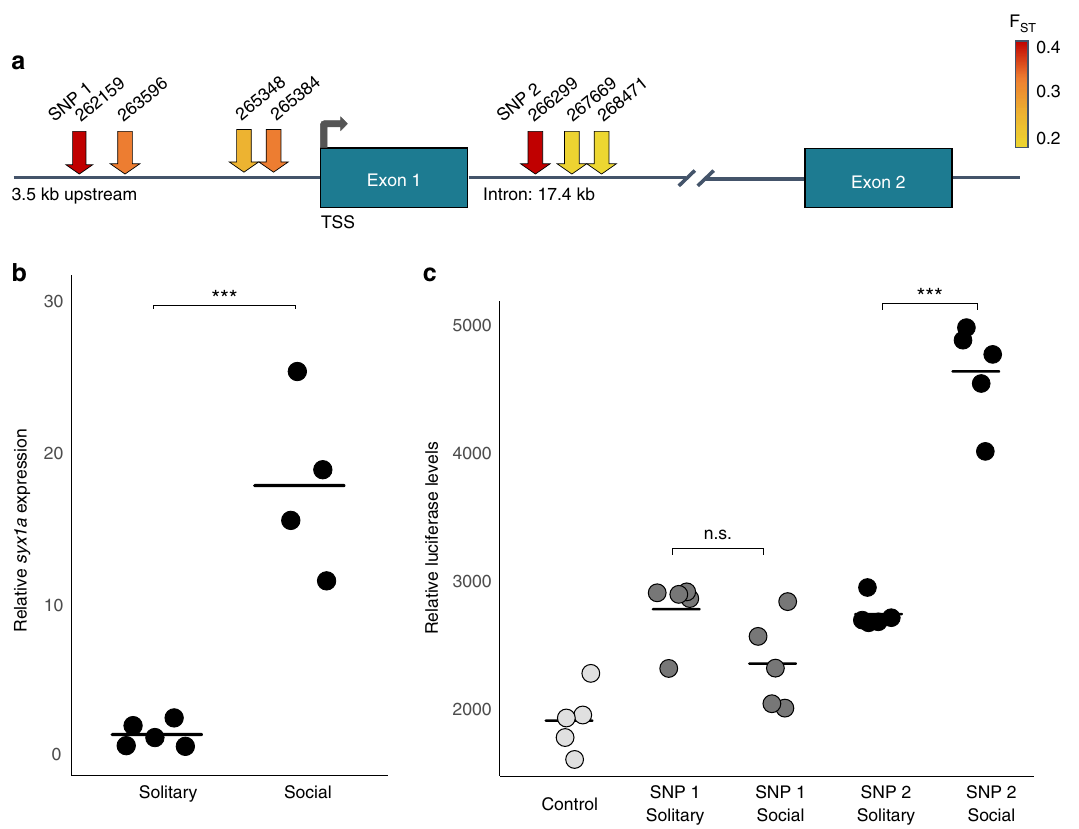
Fig. 4 Functional effects of regulatory SNPs in the syx1a locus. a Schematic of syx1a . Arrows denote locations of the seven SNPs associated with social behavior in L. albipes . Arrow colors illustrate F ST between social forms at each SNP. Two SNPs, labeled SNP 1 and 2 (red), have the highest F ST estimates, and are in strong LD with each other (r 2 = 0.803), compared with the mean pairwise value among all seven SNPs (r 2 = 0.18). b Quantitative PCR identi fi ed differences in syx1a brain gene expression between social forms. Expression values are plotted as the fold change of normalized syx1a expression levels. Social individuals ( n = 4) have signi fi cantly higher levels of syx1a brain gene expression than solitary individuals ( n = 5; t -test, t = − 6.32, p = 0.0004). c Luciferase reporter assays test if candidate SNPs in the regulatory regions of syx1a affect enhancer activity ( n = 5 replicates per group). Both tested regions show enhancer activity relative to control (Tukey ’ s honestly signi fi cant difference (HSD) post-hoc test, p < 0.05). There is no signi fi cant difference between social and solitary alleles of SNP 1 (Tukey ’ s HSD, p = 0.1773), but the social allele of SNP 2 drives ~1.5 times higher reporter expression than does the solitary allele (Tukey ’ s HSD, p < 0.0001), consistent with the qPCR assay ( b